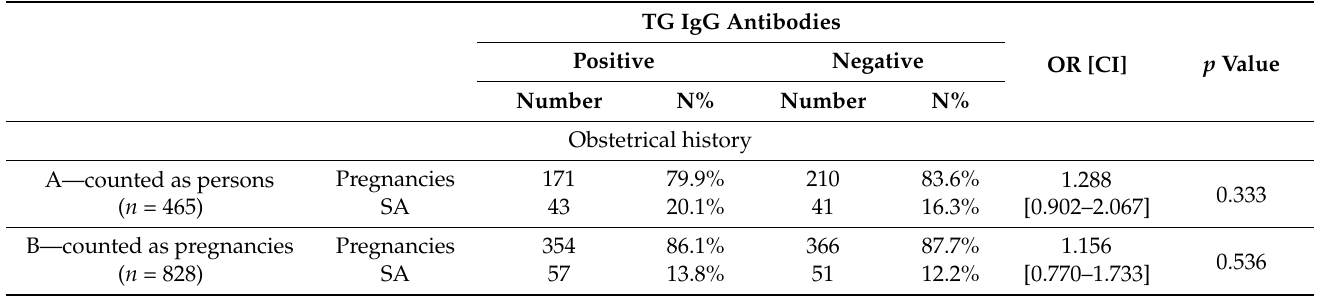
Table 2. Association between latent Toxoplasma gondii infection and history of spontaneous abortion.